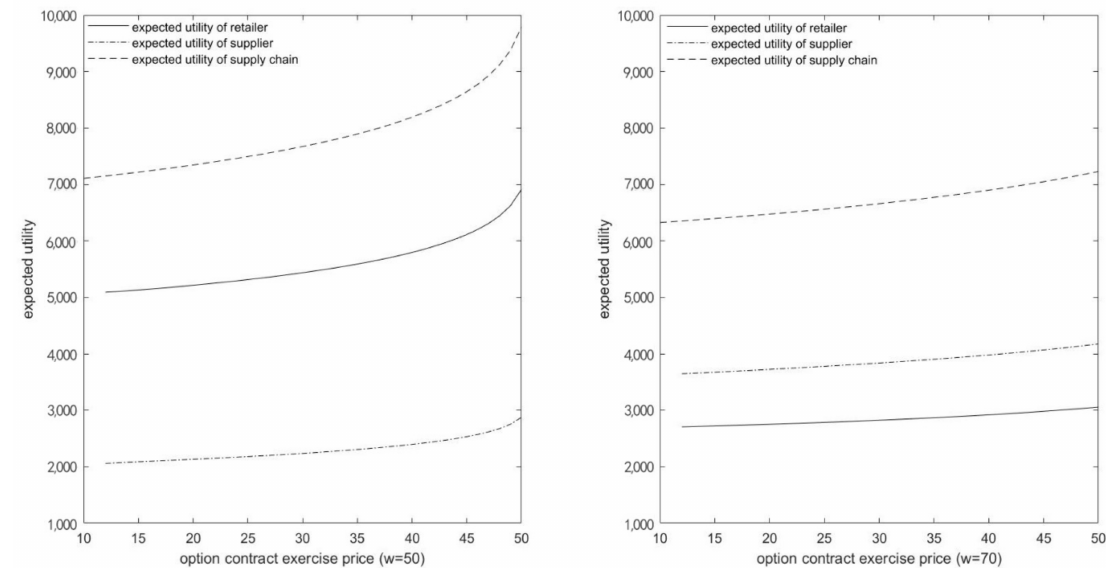
Figure 5. Comparison of expected profit under different wholesale